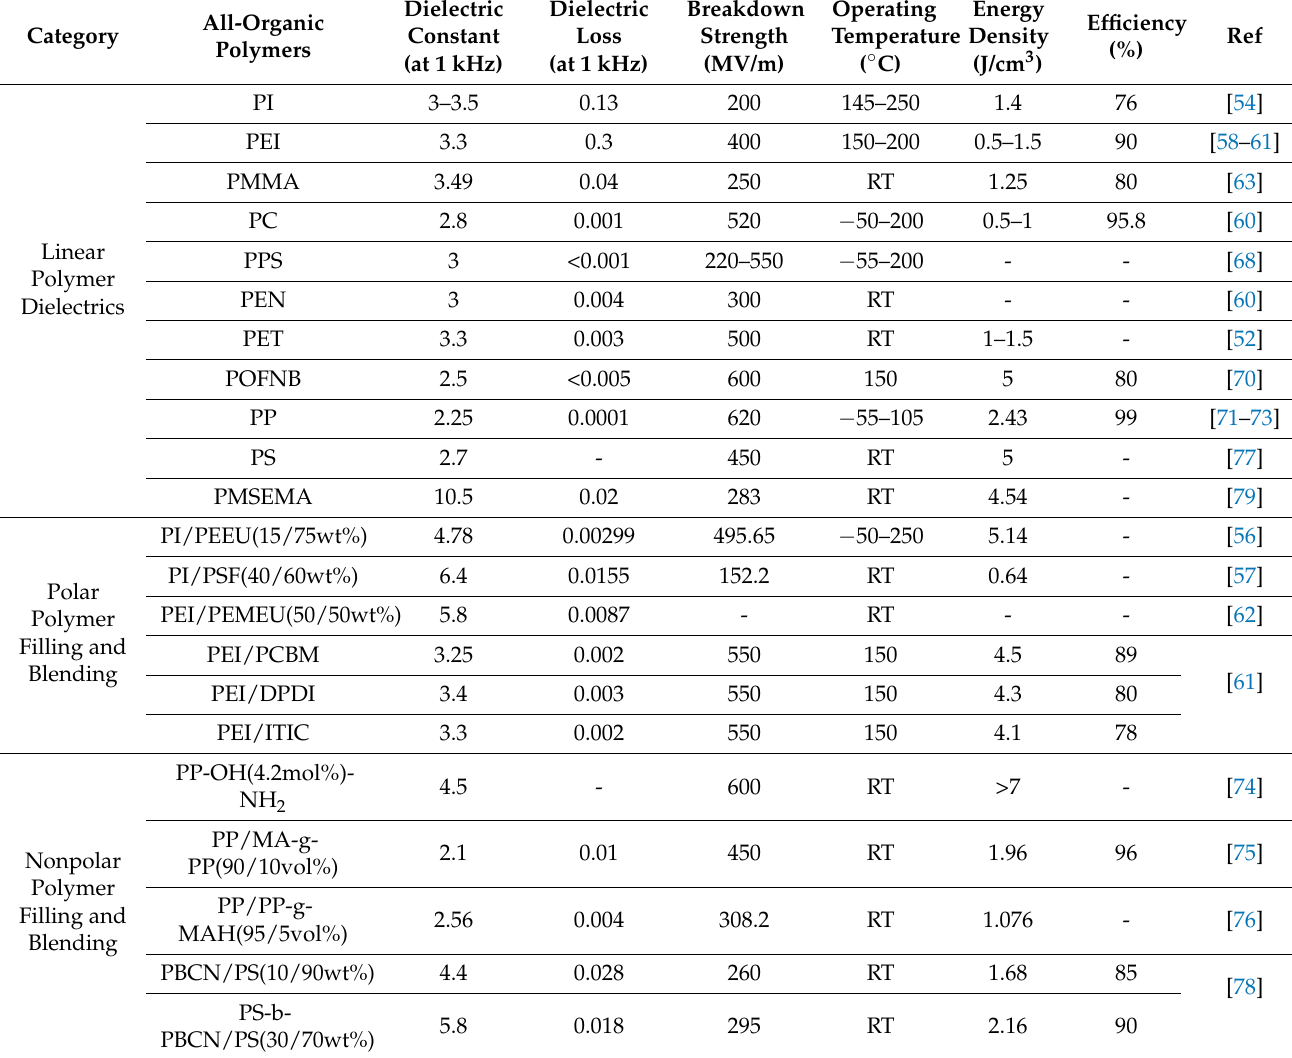
Table 1. Dielectric and Energy Storage Properties of Linear Polymer